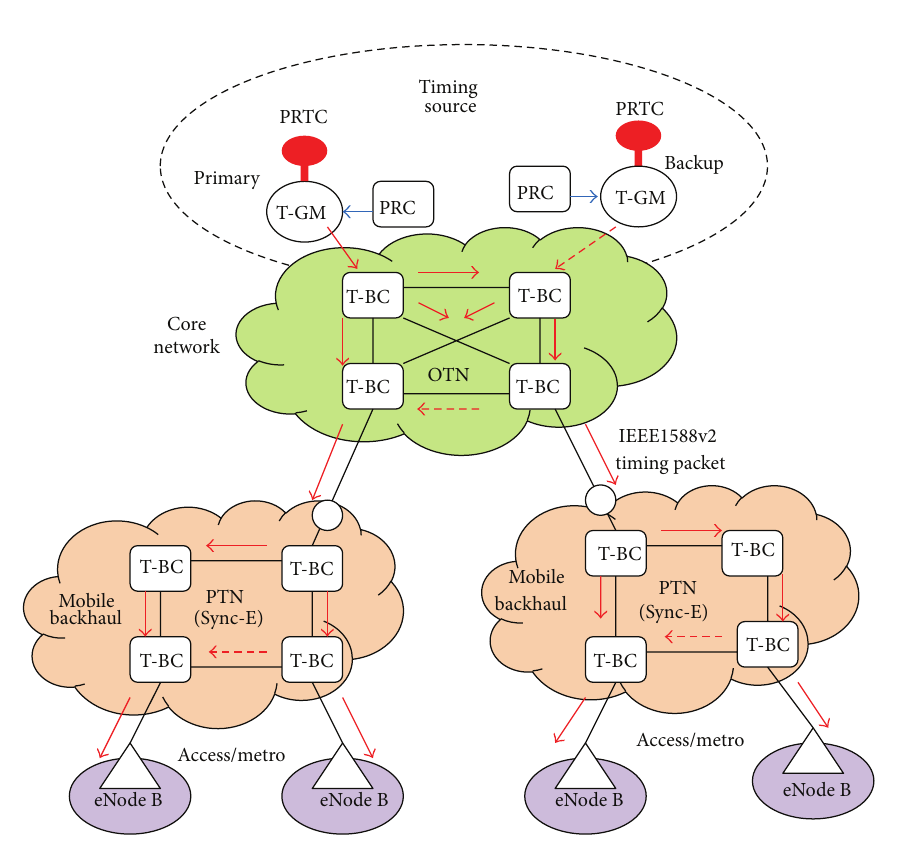
Figure 9: Time/phase over OTN networks with T-BC